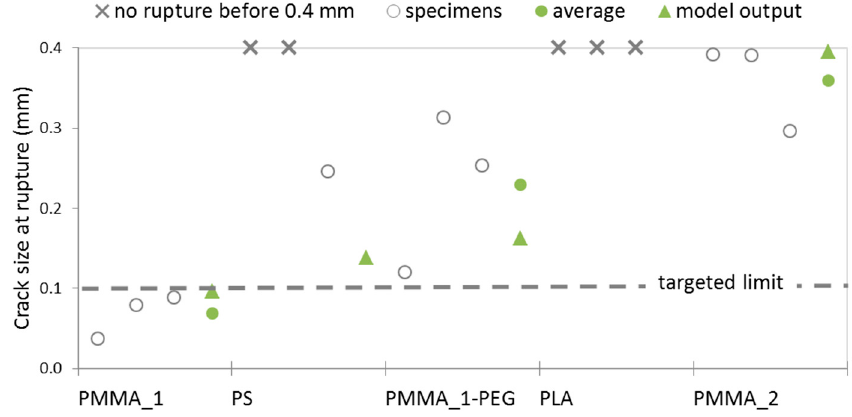
Figure 10. Crack size at the moment of rupturing of the capsules, in relation to the targeted maximum crack size of 100 μ m.